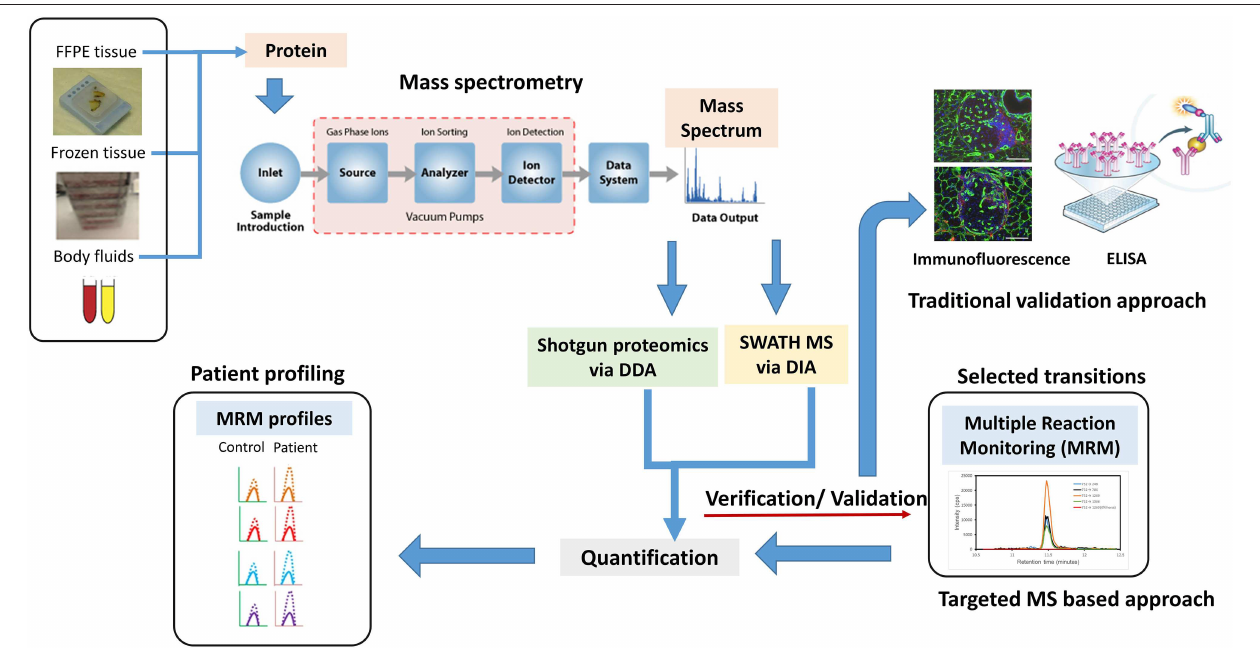
FIGURE 2 | A new age proteomic approach for better validation for biomarker for prostate cancer (PCa) to improve diagnosis and prognosis. A shotgun proteomic approach via data-dependent acquisition (DDA) in combination with sequential window acquisition of all theoretical fragment–ion spectra (SWATH)–MS via data-independent acquisition (DIA), integrative proteomics is a better proposition in identifying biomarkers and protein signatures for improving PCa diagnosis, managing disease, and predicting treatment outcomes. Traditional approaches like immunofluorescence, Western blotting, and ELISA can be replaced by MS-based targeted approaches such as multiple reaction monitoring (MRM) to detect, distinguish, and quantify specific biomarkers obtained from specific samples sets. MRM profile image adapted from Arora et al. (